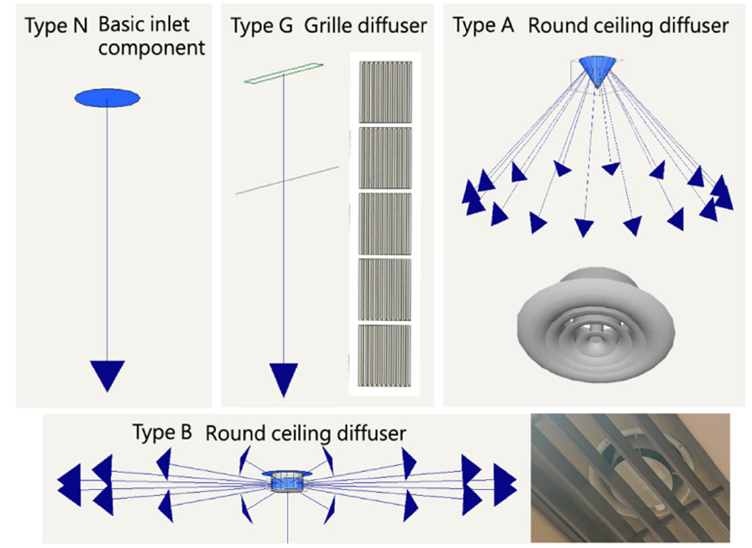
Figure 4. Different types of air inlets in the model.